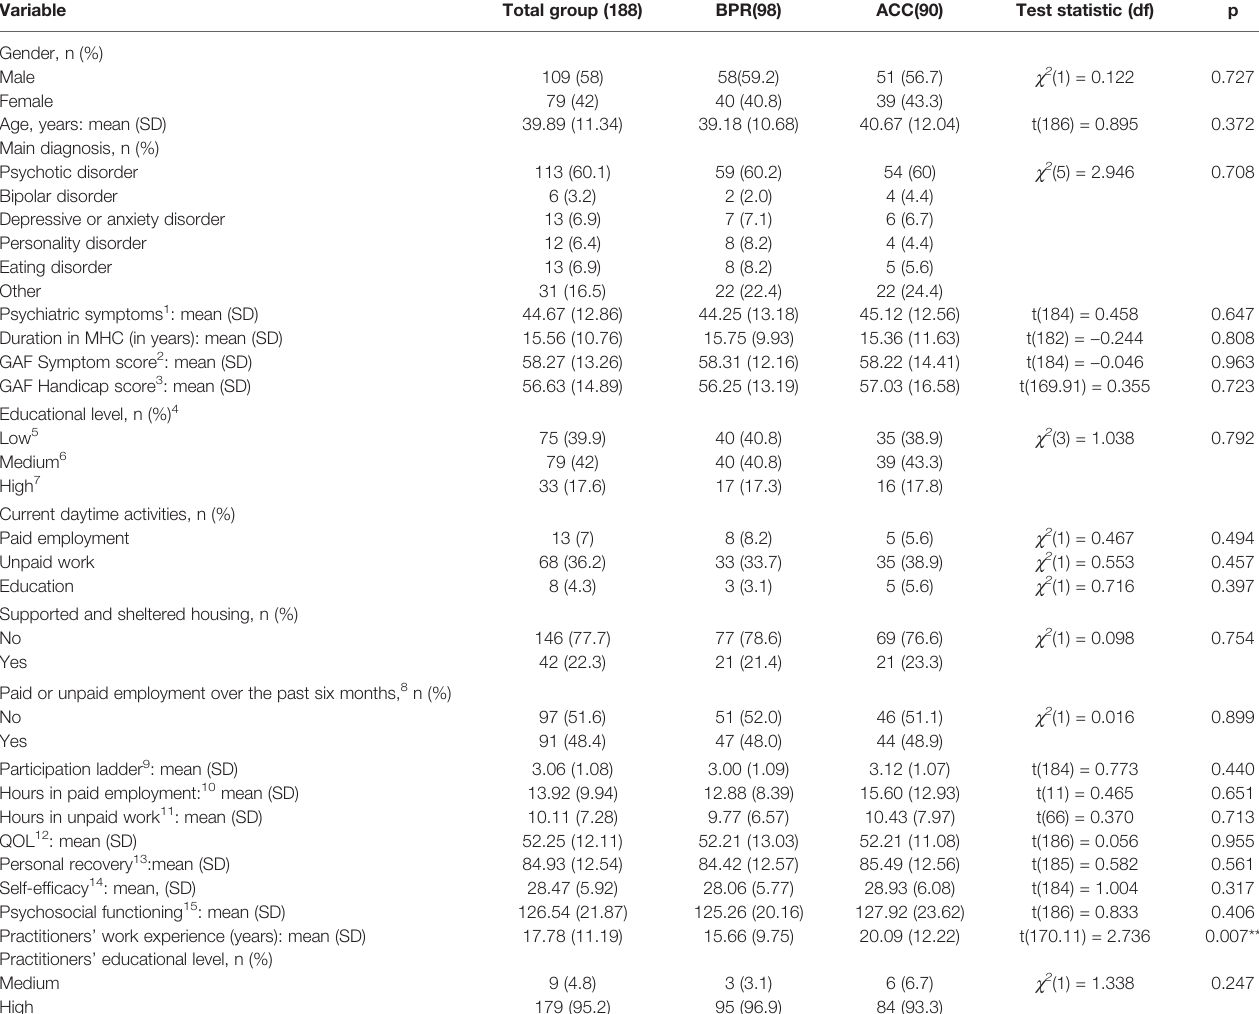
TABLE 1 | Baseline characteristics of study participants and MHC workers, and differences between BPR and ACC